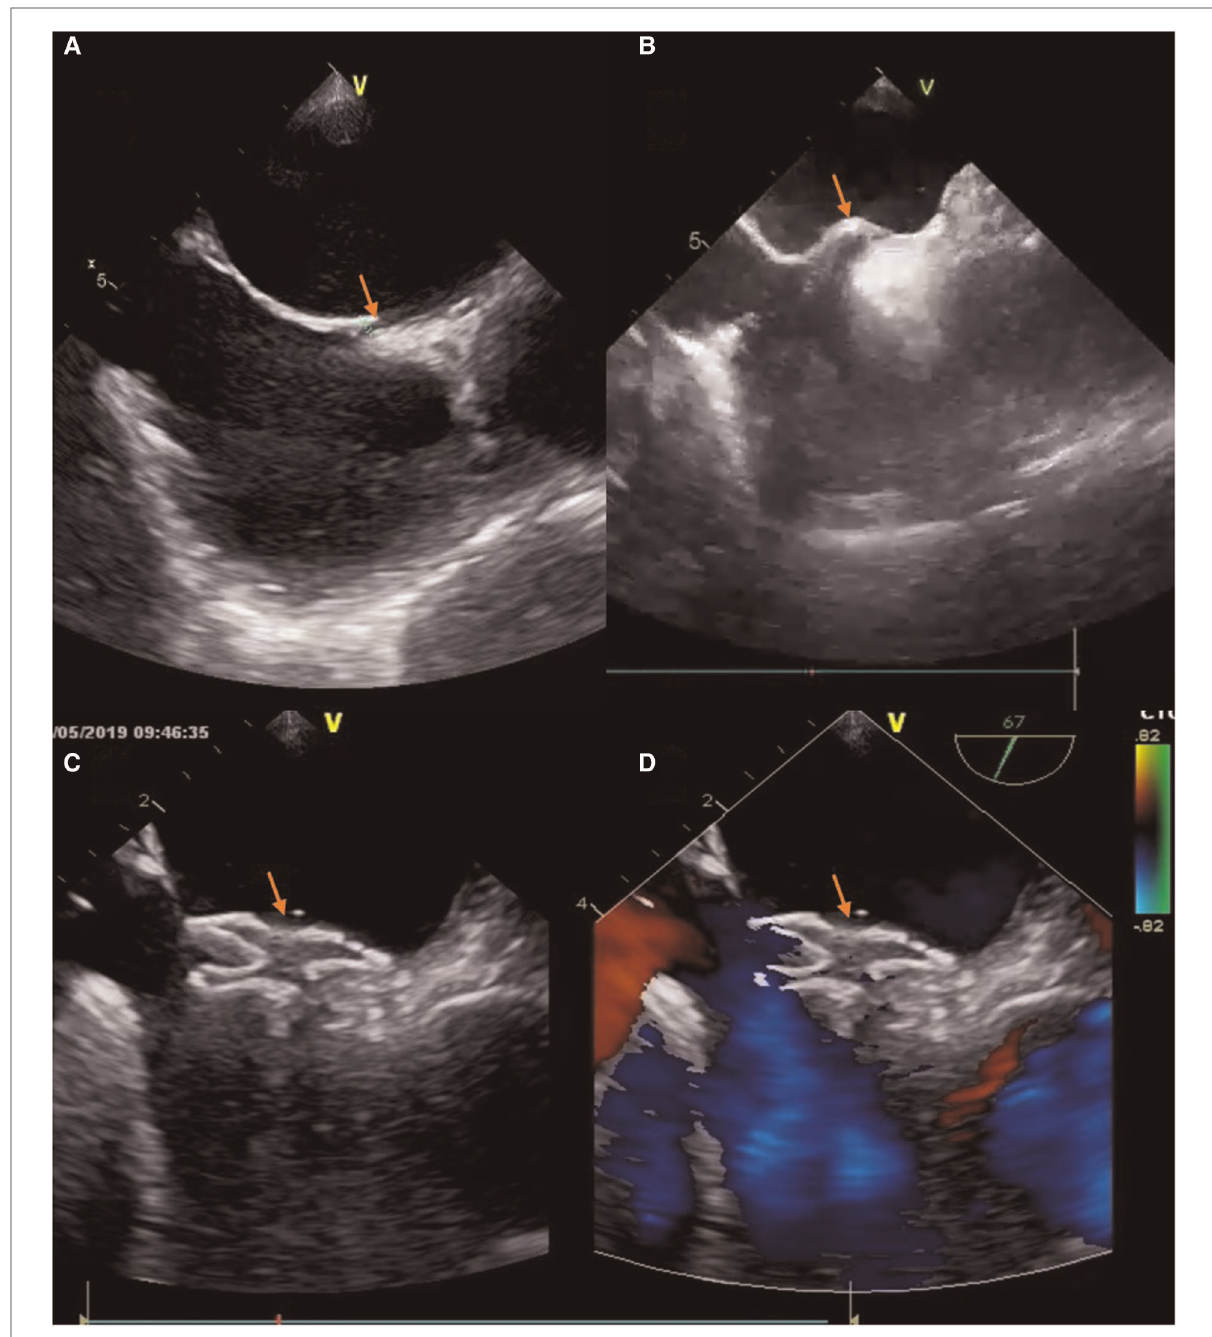
FIGURE 1 The process of deploying a PFO occluder. ( A ) The tunnel of PFO was appeared in TEE ( “ yellow arrow ” ). ( B ) The atrial septum was jacked up like a “ tent ” by a catheter ( “ yellow arrow ” ). ( C ) The device was positioned well ( “ yellow arrow ” ). ( D ) No residual colour fl ow crossed the atrial septum after the device was deployed ( “ yellow arrow ”